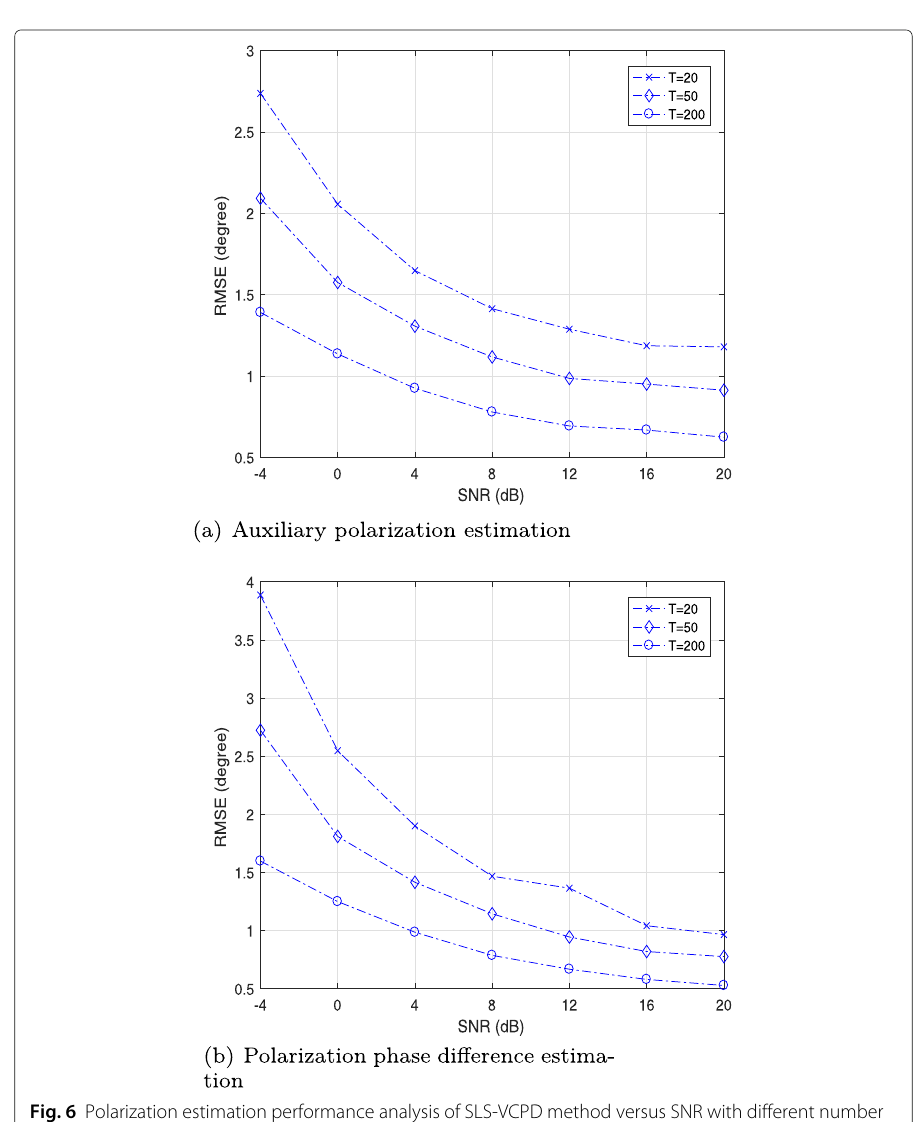
Fig. 6 Polarization estimation performance analysis of SLS-VCPD method versus SNR with different number of samples. A nested EMVS array is equipped with M = 6 sensors. The number of sources is set as K =